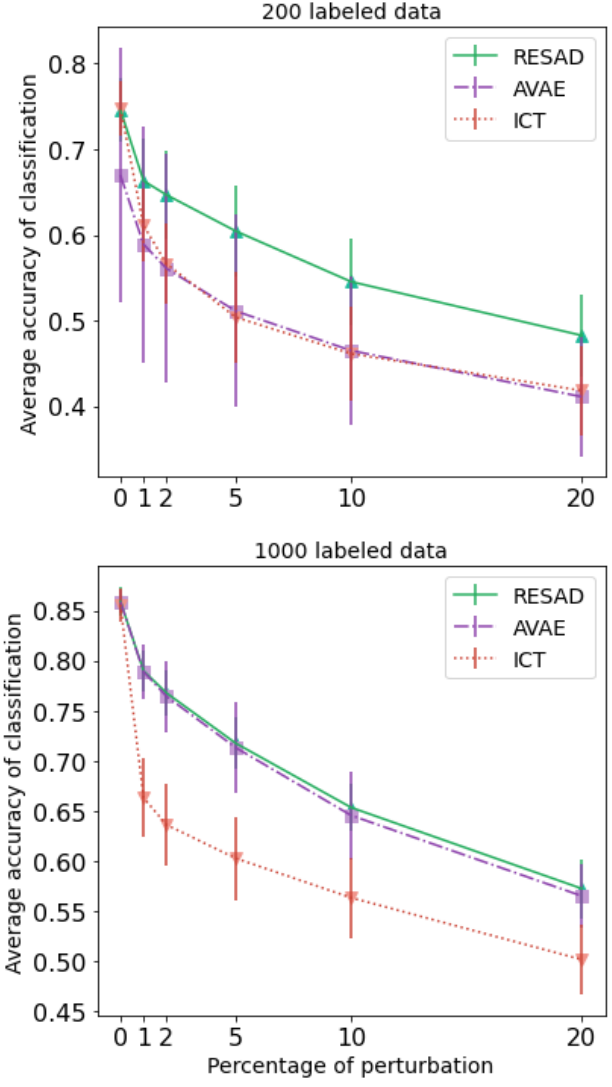
Figure A3. Average classification accuracy comparison for our proposed model compared to AVAE and ICT, with 200-sample and 1000-sample labeled data, with respect to increasing perturbation percentages.